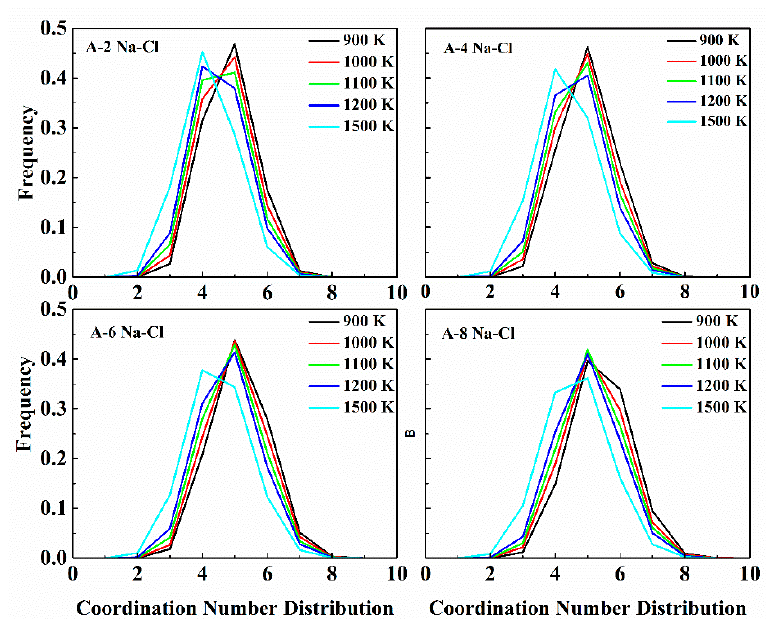
Figure A6. The coordination numbers distribution of four compositions at various temperatures: Na-Cl.